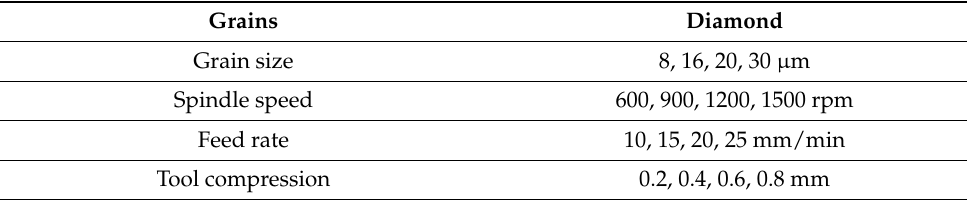
Figure 2. SAG experimental setup: ( a ) DNM415 CNC Machining Center, ( b ) SAG tool composition.